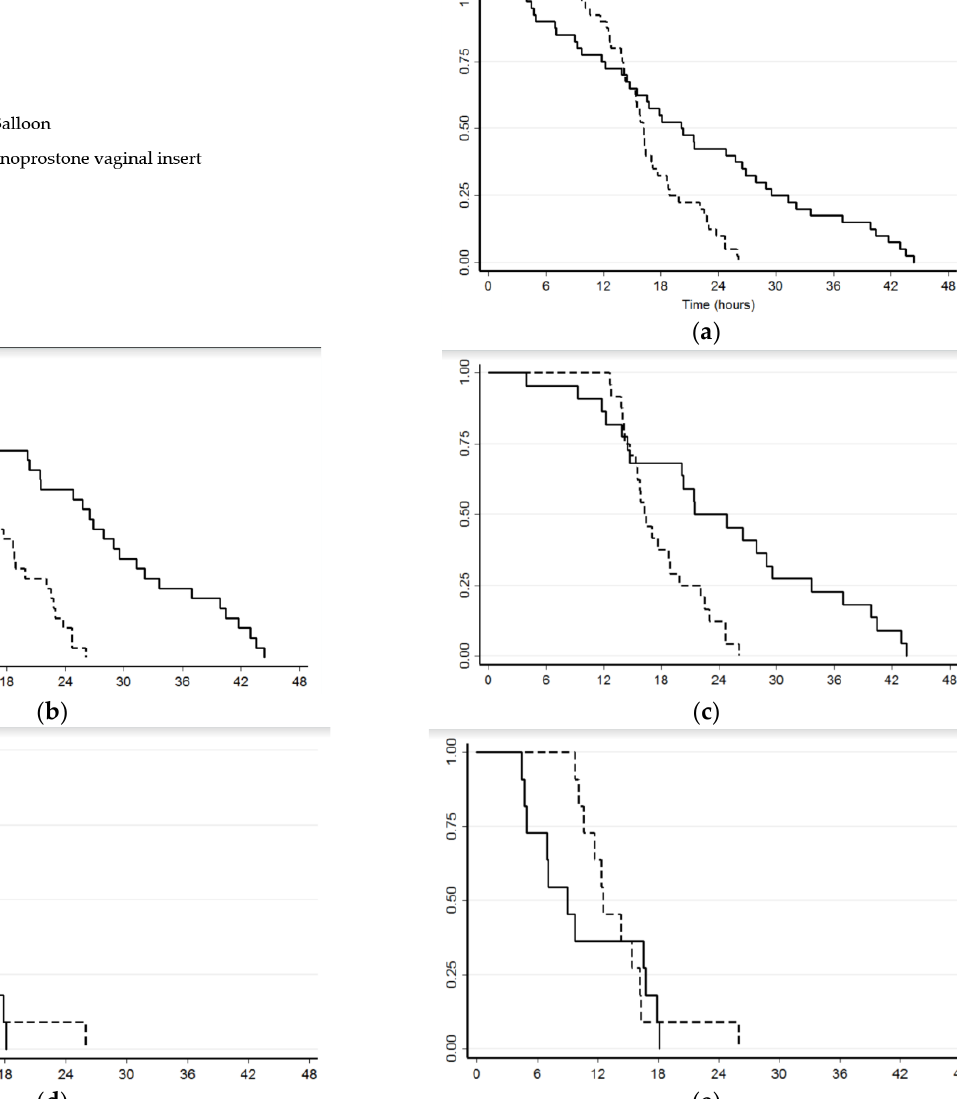
Figure 3. Kaplan – Meier survival curves illustrating induction to delivery time: ( a ) for entire study population; ( b ) for nulliparous and all deliveries modes; ( c ) for nulliparous and vaginal delivery; ( d ) for multiparous and all deliveries modes; ( e ) for multiparous and vaginal delivery. In nulliparous women ripened using a double balloon catheter (plus oxytocin), the study found reduced TID (17.0 versus 26.5 h, ES = 0.62 (0.10 to 1.14), p = 0.006), a significantly higher rate of delivery <24 h (89.6% versus 41.4%, absolute difference = 48% (27 to 69), p = 0.001), vaginal delivery <24 h (87.5% versus 50%, absolute difference = 38% (13 to 62), p = 0.01), and shorter induction to active labor time (10.0 [7.5; 12.5] versus 14.7 [9.7; 23.6] h, ES = 0.69 (0.03 to 1.31), p = 0.03). However, the reduction in delay between induction and full cervical dilatation did not reach significance (14.5 [12.2; 19.1] versus 19.9 [13.1; 29.5] h, ES = 0.45 ( − 0.13 to1.02), p = 0.06) (Table 2). Ripening device removal or oxytocin discontinuation for abnormal FHR rates were similar between the two groups, as were rates of uterine hyperstimulation and caesarean section (12.5% versus 17.5%, p = 0.75). Despite oxytocin quantities being significantly higher in the double balloon catheter (plus oxytocin) group, no differences were found in postpartum hemorrhage rates (Table 3) or neonatal outcomes (Table 4).